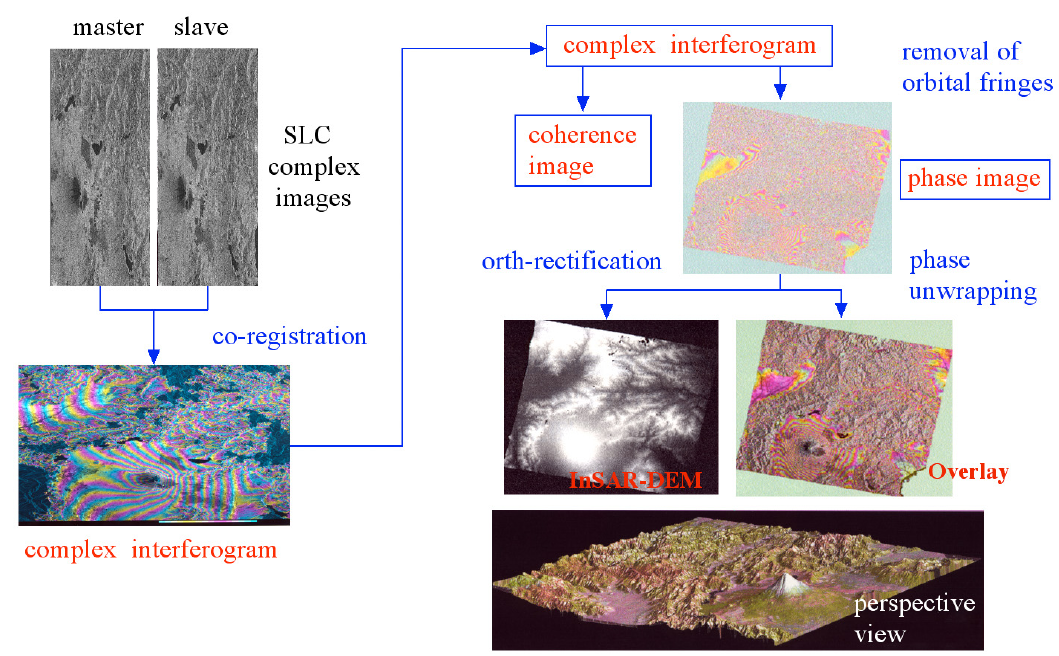
Figure 11. Flow of CT-InSAR DEM